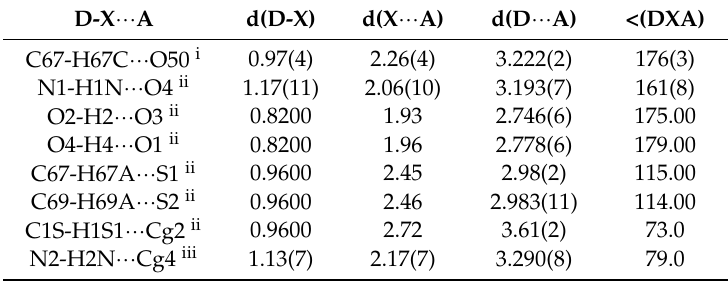
Table 2. Hydrogen-bond and intermolecular interactions (Å, °).